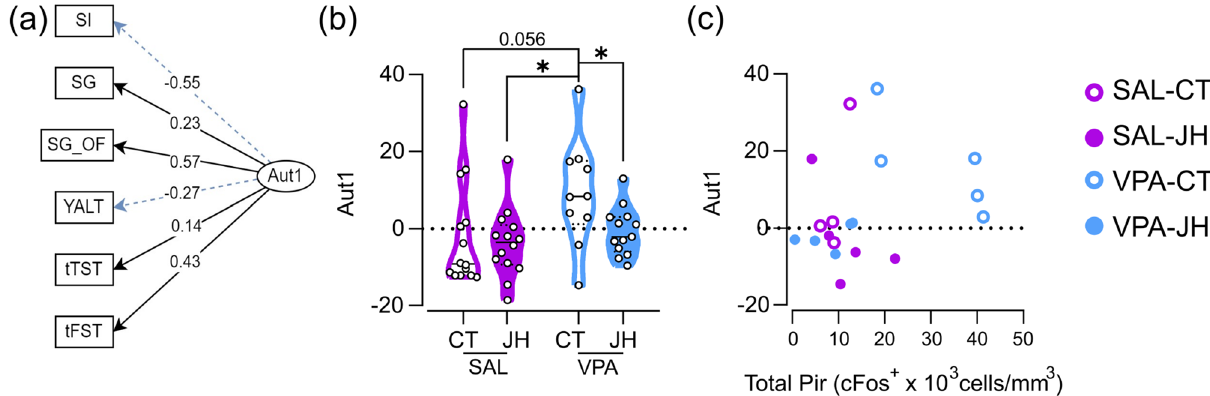
Figure 5. Effect of VPA and JH on an “autism” factor (Aut1). ( a ) Loading values of individual behaviors in the Aut1 factor. SI sociability index, SG self-grooming time, SG_OF time spent grooming in the open field, YALT percentage of alternations in the Y-maze, tTST time spent immobile in the TST, tFST time spent immobile in the FST. Blue, dashed lines indicate negative loadings. ( b ) VPA-CT animals show higher Aut1 scores than all other groups. Data are shown as individual values (dots) and violin plots. LME model followed by Tukey’s post hoc comparisons, *p < 0.05. N SAL-CT = 14, N SAL-JH = 14, N VPA-CT = 10, N VPA-JH = 13. ( c ) VPA-CT animals show high cFos-positive cell density in the Pir and high Aut1 scores, that discriminates them from the other experimental groups. Each animal is represented by a dot. N = 4–5 per